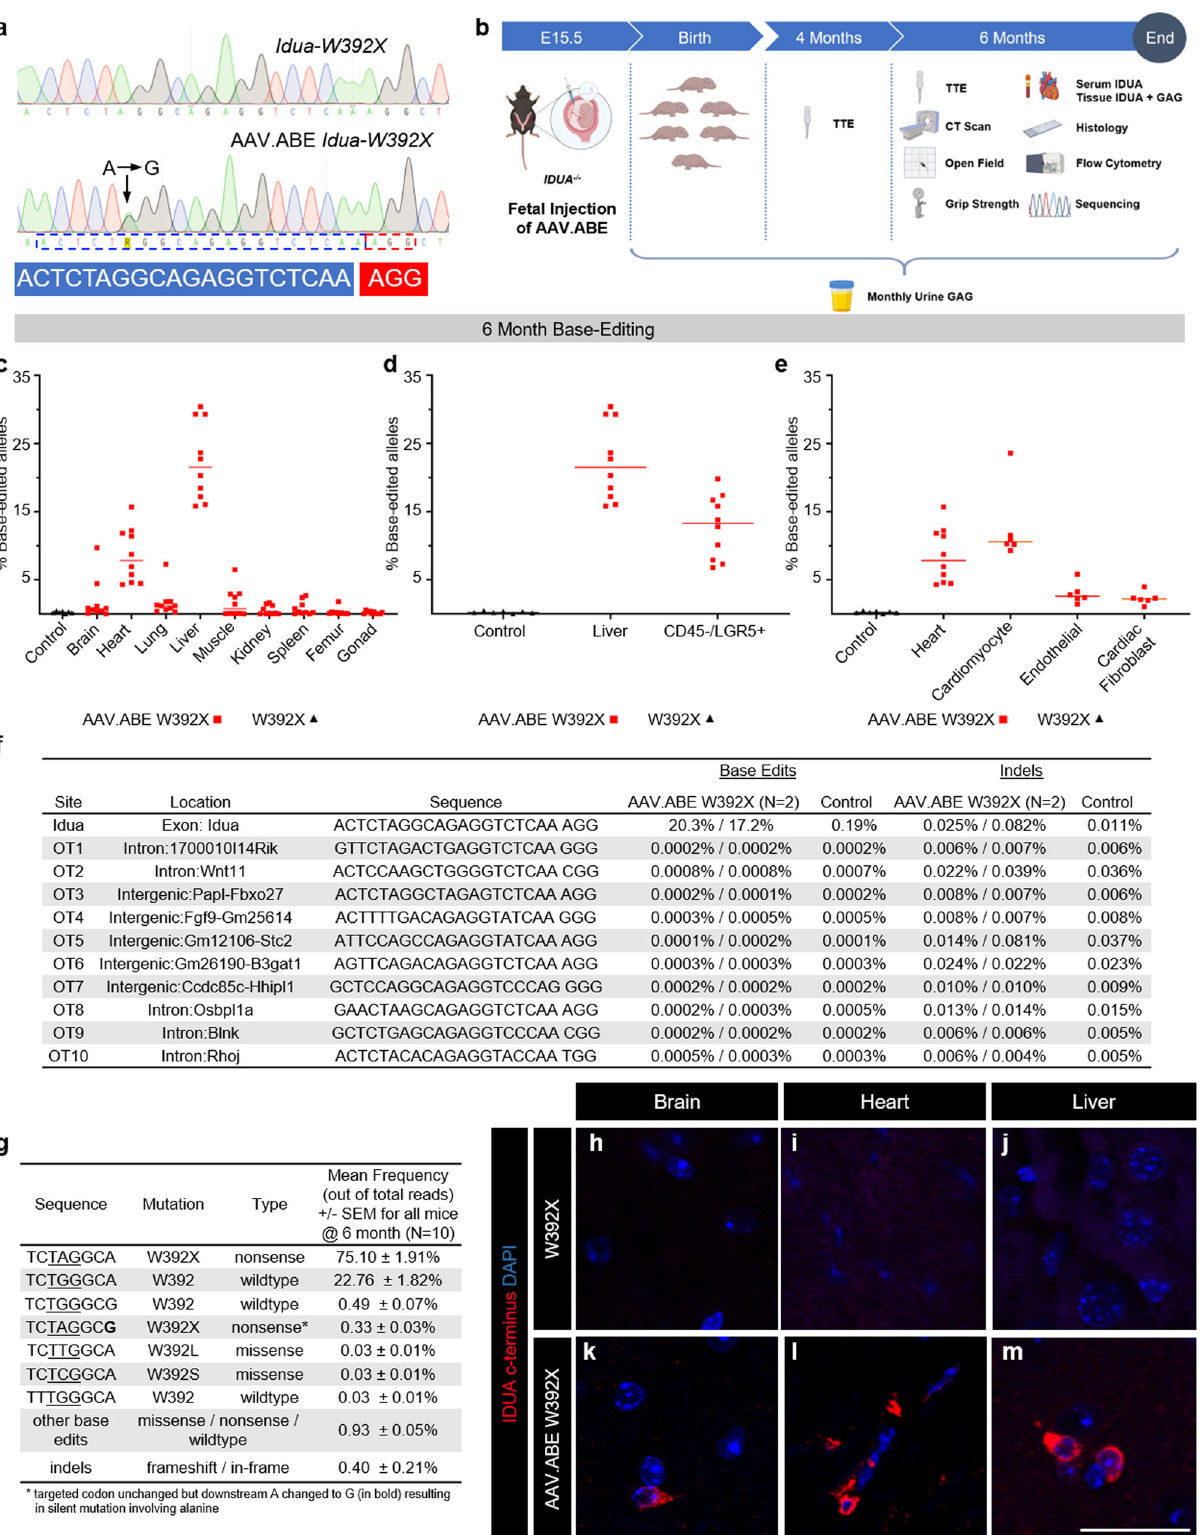
Idua- W392X fetuses were injected via the vitelline vein with AAV.ABE.Idua. sequencing and next-generation sequencing (NGS) at 1 month of age demonstrated ef fi cient heart (14.7, 13.1%) and liver (31.1, 22.4%) editing and low-level brain editing (1.9, 0.66%) (Fig.